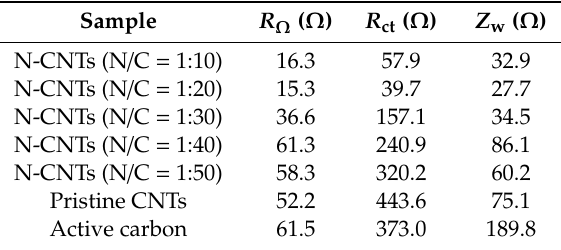
Table 2. The EIS test of N-CNT arrays with N / C feed ratio of 1:20 as the air electrode